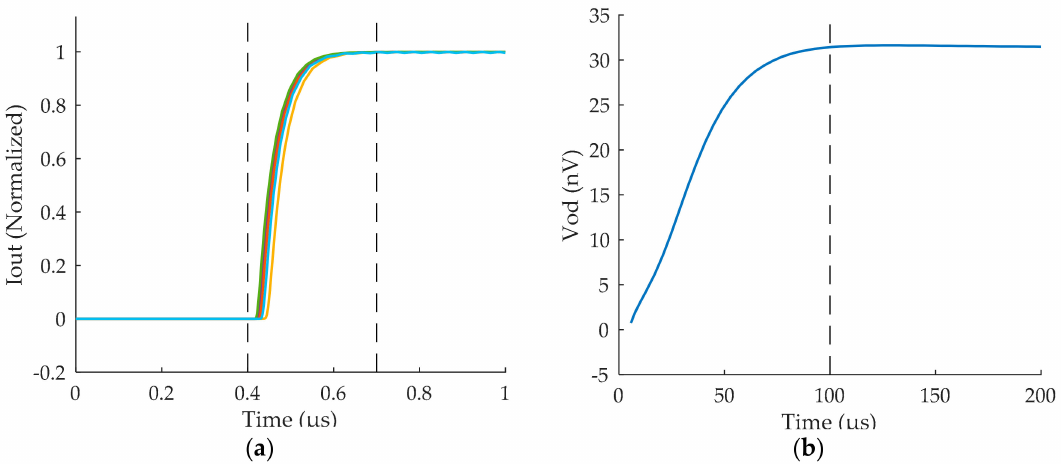
Figure 9. ( a ) Settling time of Gaussian convolution units; ( b ) Settling time of